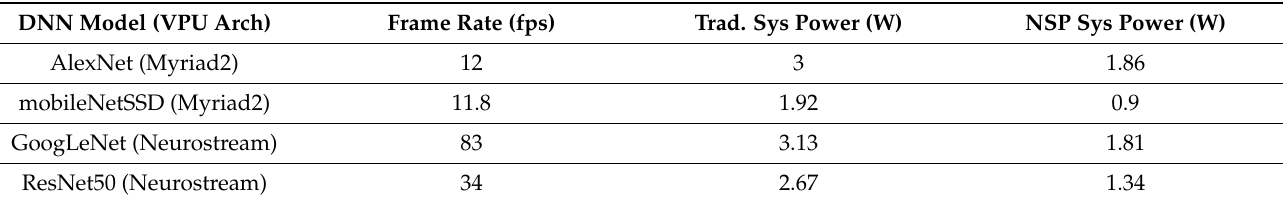
Table 2. Deep neural network (DNN) models and corresponding power